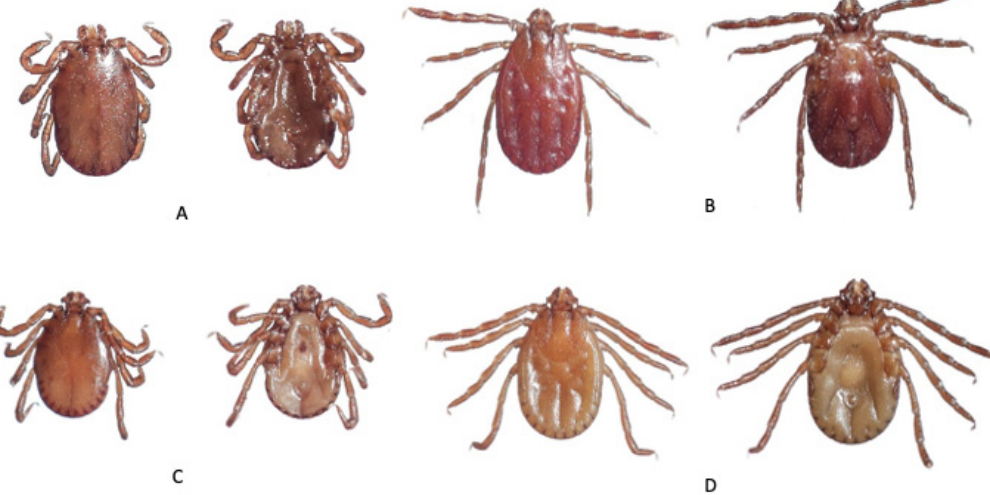
Figure 4. Dorsal and ventral views of male ( A ) and female ( B ) of Amblyomma testudinarium ; and female ( C ) Ixodes sp. Table 4. Tick infestation prevalence in cattle in Trashigang and Pema Gatshel districts. Tick Species